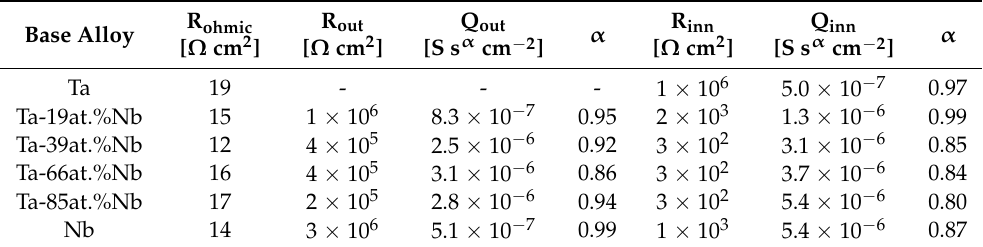
Table 4. Fitting parameters relating to EIS spectra of all the investigated 50 V anodic films using EEC shown in Figure 5b. In the case of Ta anodic oxide, R inn is R ox . Base Alloy